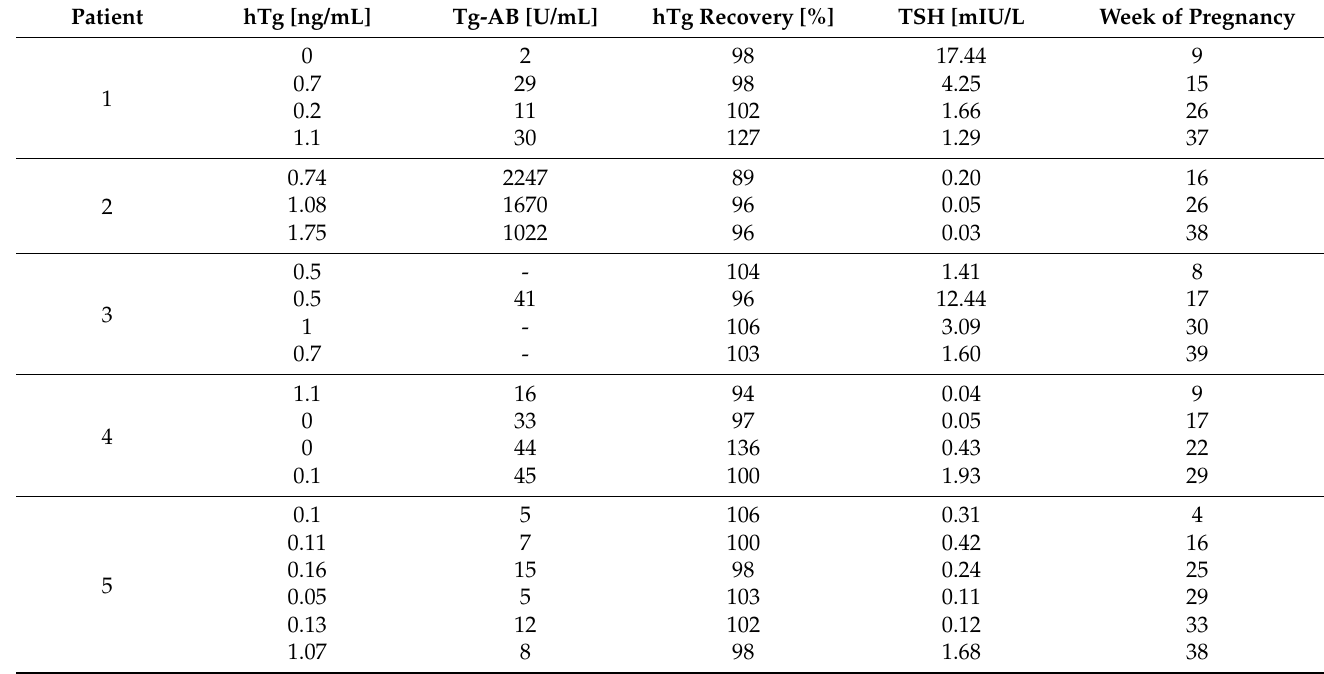
Figure 2. The evolution of the hTG over time of 5 patients with increased hTg ≥ 1 ng/mL.